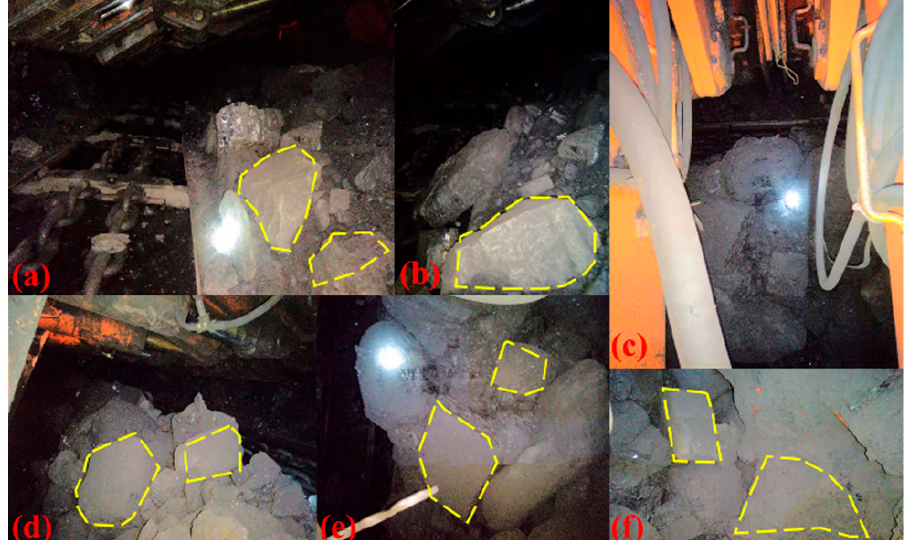
gangue caving from the back of the support).